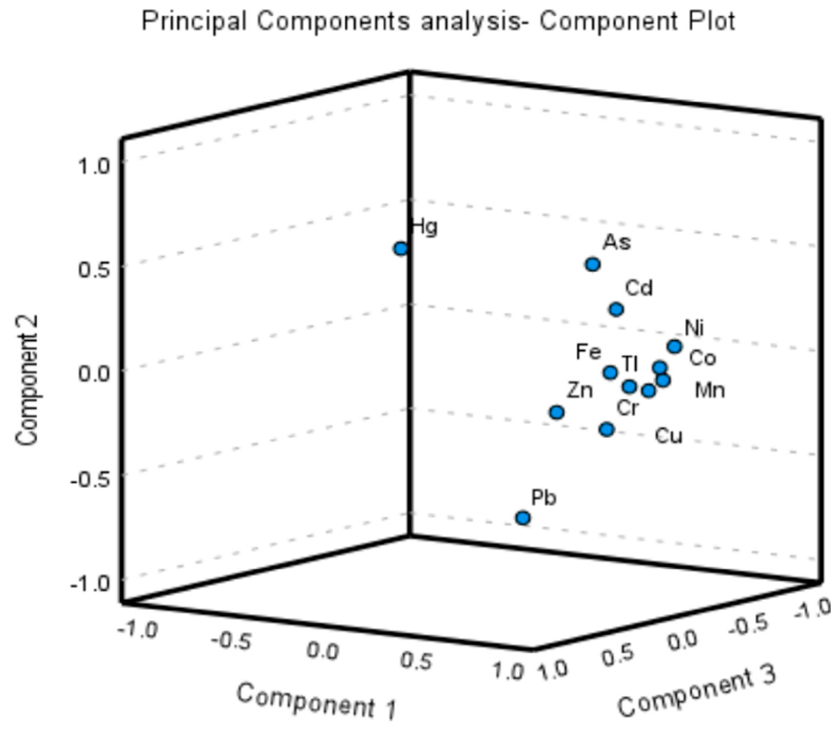
Figure 2. Component plot for heavy metal levels in the soil obtained from principal component analysis.